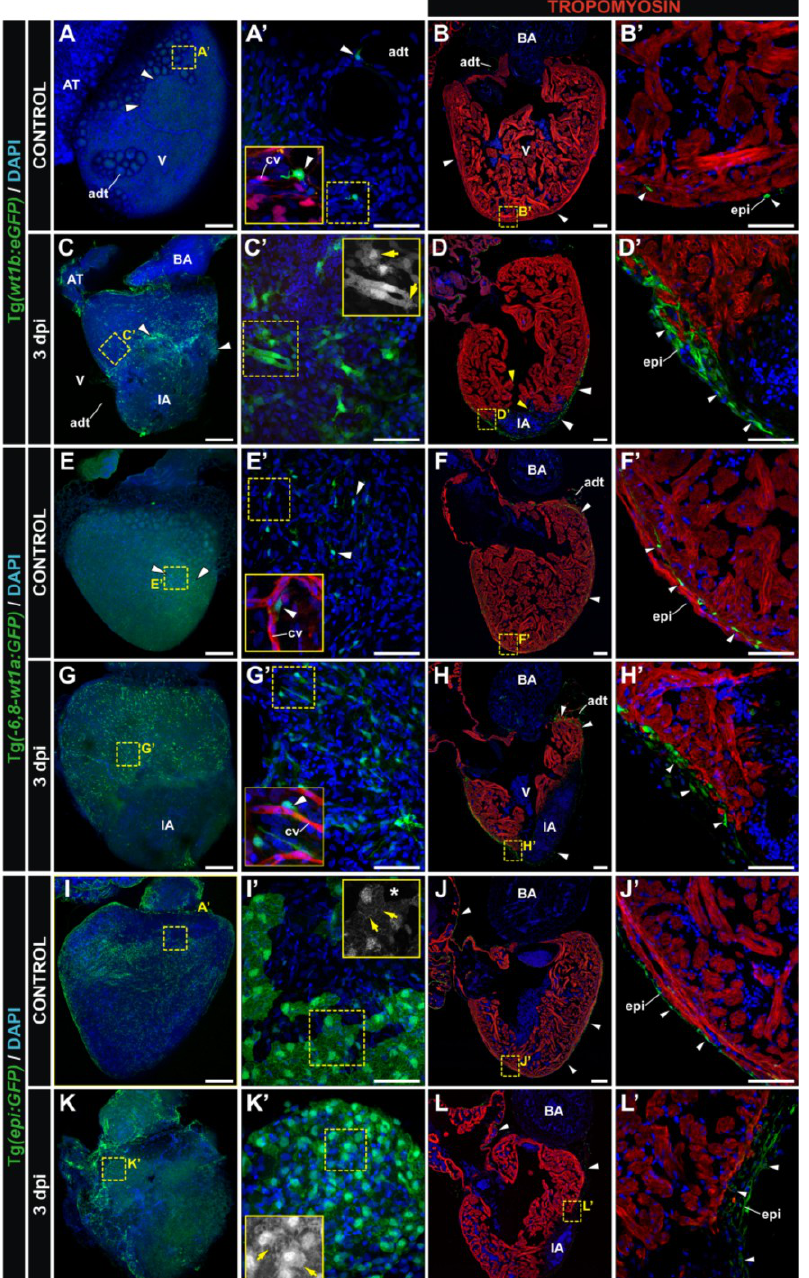
Figure 4. Transgenic reporter lines that mark the adult epicardium during regeneration. Whole mount confocal 3D projections and immunofluorescence on sections of dissected control and cryoinjured hearts at 3 days post-injury (dpi). Hearts are from the Tg( wt1b:GFP ) ( A – D ), Tg (-6.8kbwt1a:GFP) ( E – H ) and Tg( epi:GFP ) ( I – L ) lines. Anterior is to the top; ventral to the right. Nuclei are counterstained with DAPI (blue). ( A’ – L’ ) Zoomed images of the boxed areas in A–L. Insets in ( A’ ), ( E’ ) and ( G’ ) additionally show details of the coronary vasculature (red), reported by the Tg( fli1a:DsRedEx ) transgene. Insets in ( C’ ), ( I’ ) and ( K’ ) show the GFP channel from the boxed area. White arrowheads mark GFP-positive cells; yellow arrows mark morphological cell features. adt, adipose tissue; AT, atrium; BA, bulbus arteriosus; cv, coronary vessels; epi, epicardium; IA, injured area; V, ventricle. Bars: 200  m (full views), 50  m